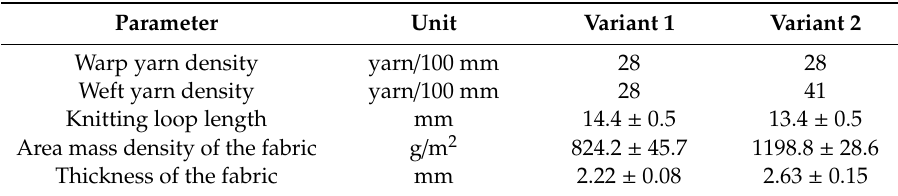
Table 2. Configuration of the two fabric